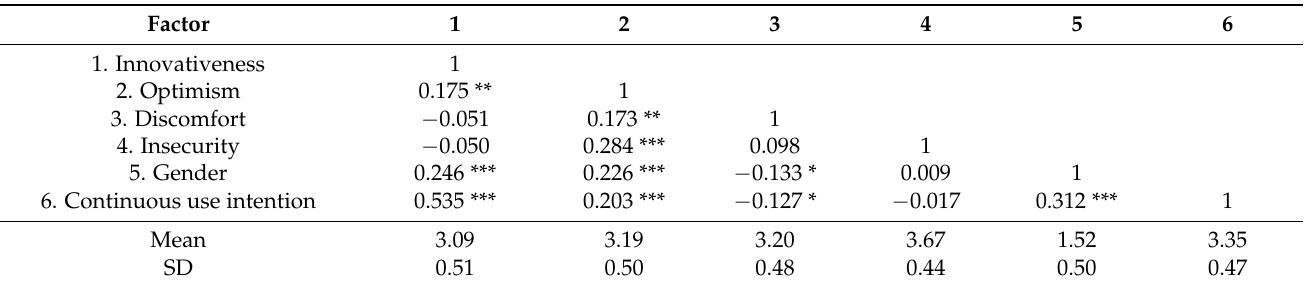
Table 3. Descriptive statistics and correlation analysis between the variables.